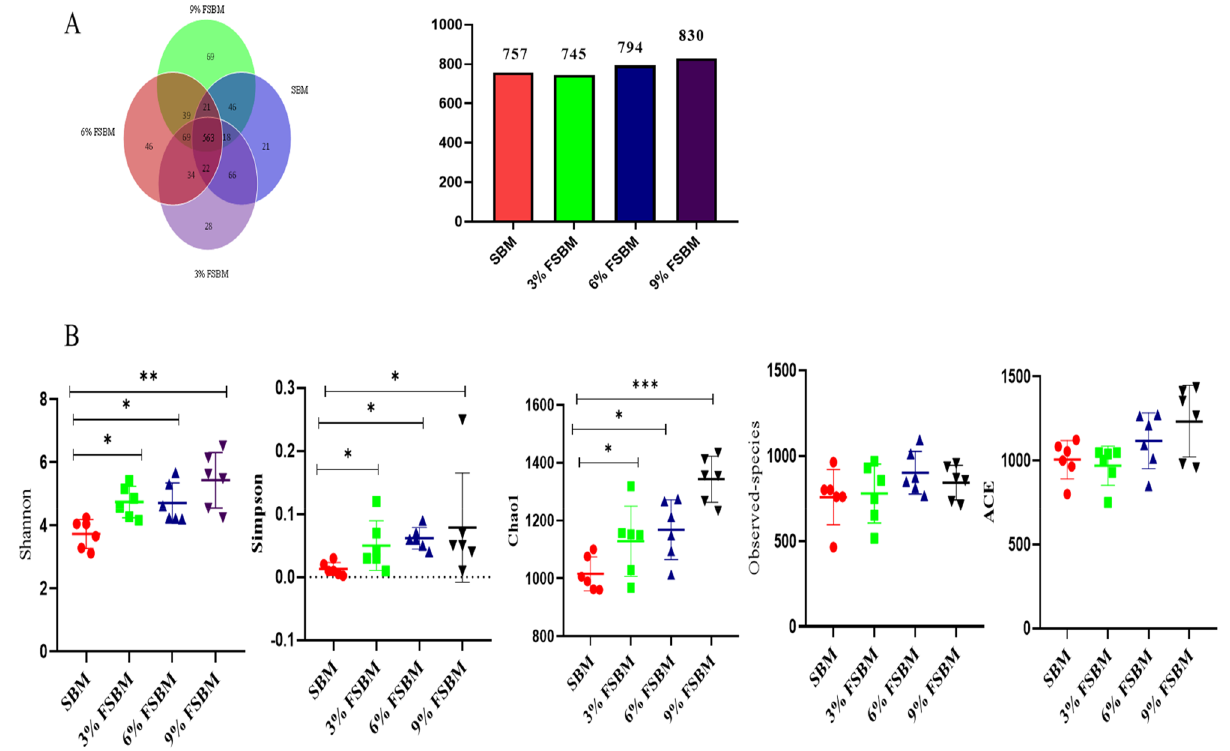
Figure 5. Fecal microbial richness and diversity. ( A ) Venn diagrams of dietary treatments at the OTUs levels. ( B ) Microbial richness estimates (Observed species, Chao, and Ace) and diversity indices (Shannon and Simpson). * P < 0.05, ** P < 0.01. SBM, soybean meal; FSBM, fermented soybean